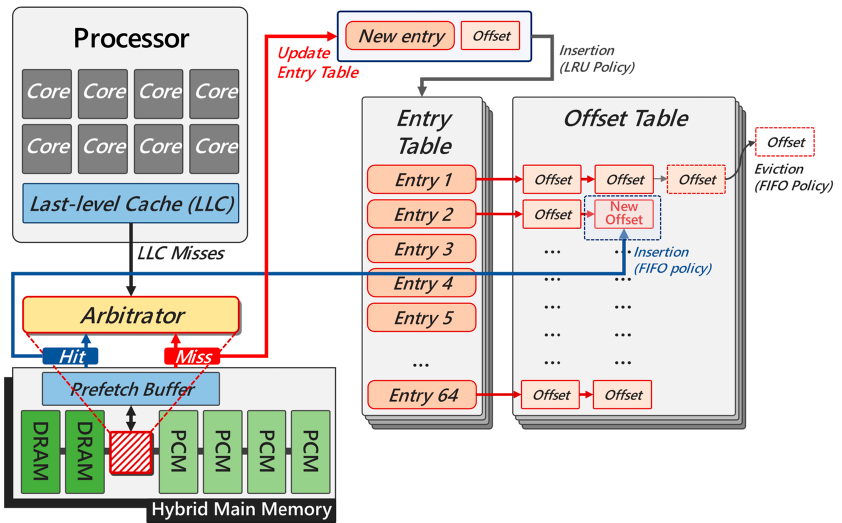
Figure 5. Update flow of prefetch table.